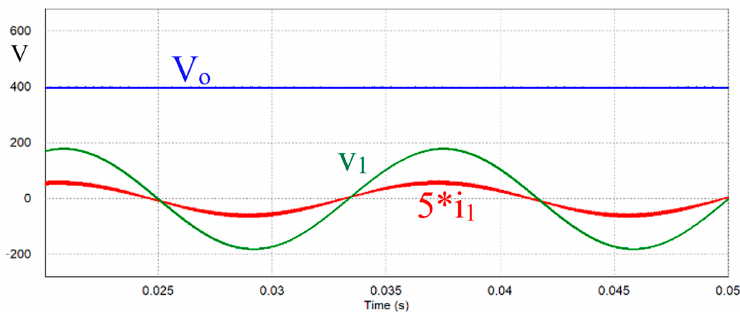
Figure 7 Figure 6. Output voltage V o , input voltage (v 1 ), and current (i 1 ).